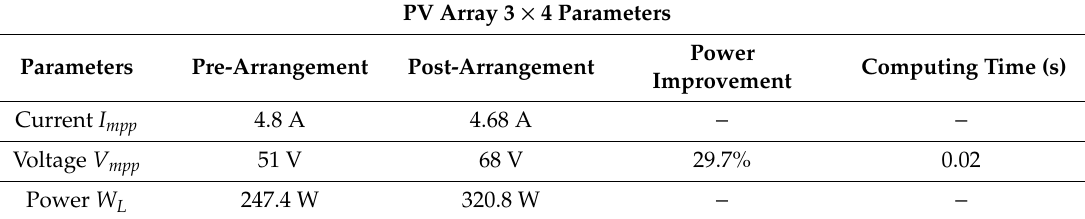
Figure 11. The output of the Array (pre-post rearrangements) for case 1. Table 4. PV array 3 × 4 parameters of Pre-Post arrangements.